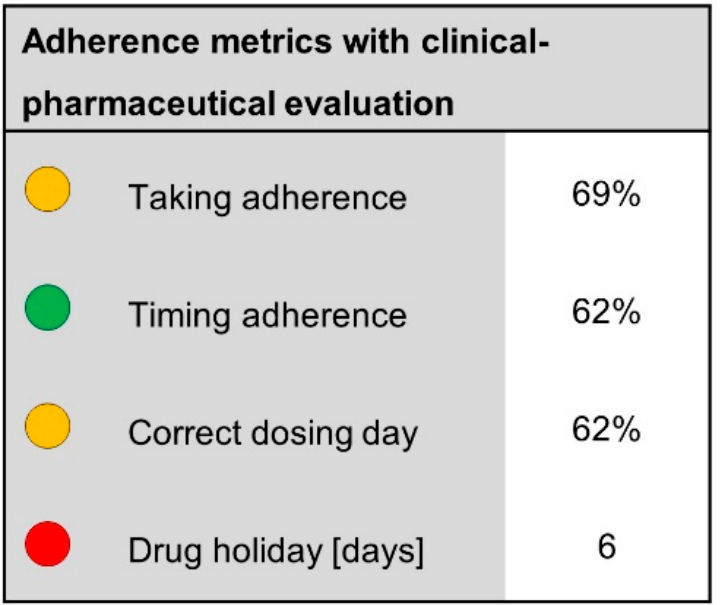
Figure 3. Adherence values with clinical–pharmaceutical evaluation; the values are depicted as circles with traffic light colors (green: satisfactory, yellow: unsatisfactory, red: critical).